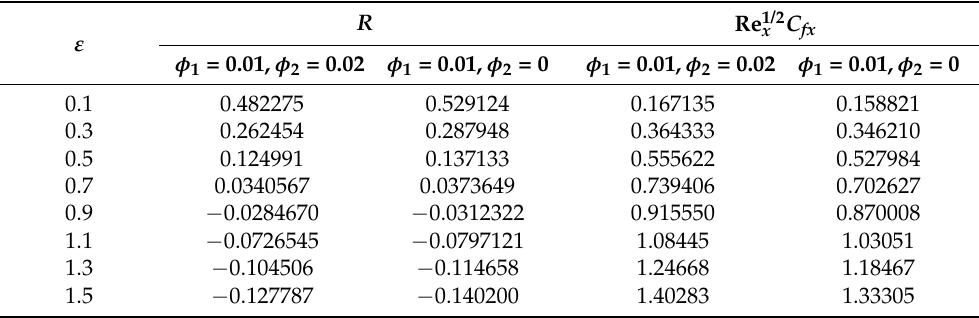
Table 10. As the unsteadiness parameter ε undergoes variation, numerical approximations are made for the values of both the dimensionless film thickness or R and the local skin friction co- efficient Re 1/2 x C fx . These approximations are based on specific parameters including We x =